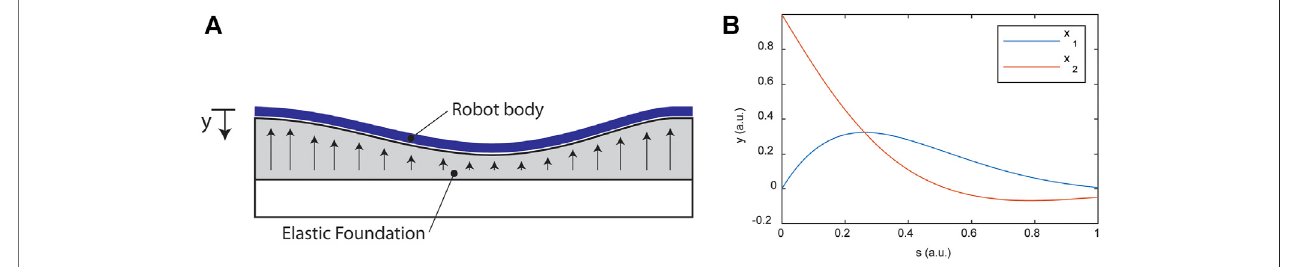
FIGURE 7 | (A) Schematic diagram for the beam on an elastic foundation as a model for a continuum robot interacting with soft tissue. (B) Example with β (cid:2) 3, showing the shape of the displacement that must be approximated.